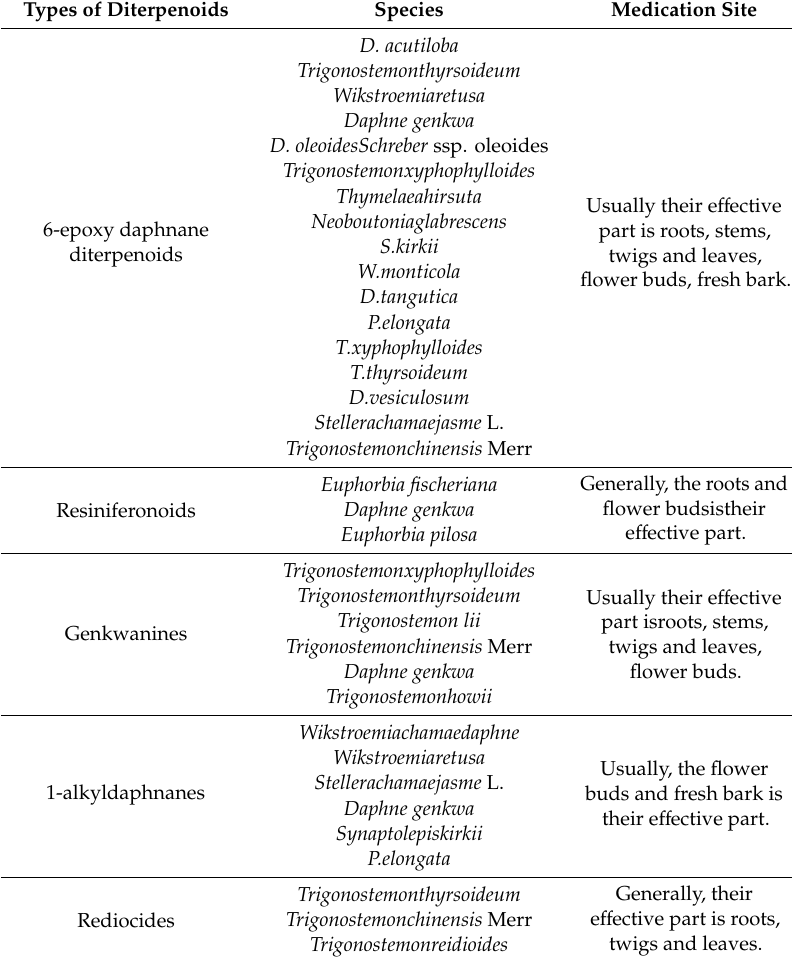
Table 1. The species of daphnane-type